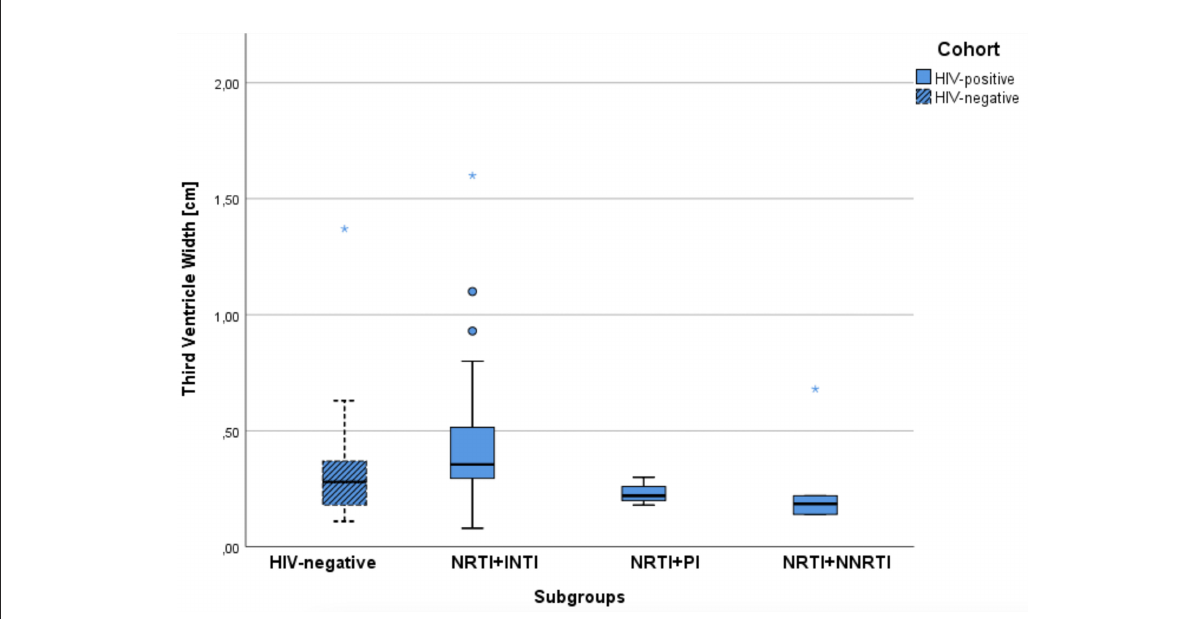
FIGURE2 Comparison of median width of the third ventricle for the control group and the ART subgroups of PLWH.